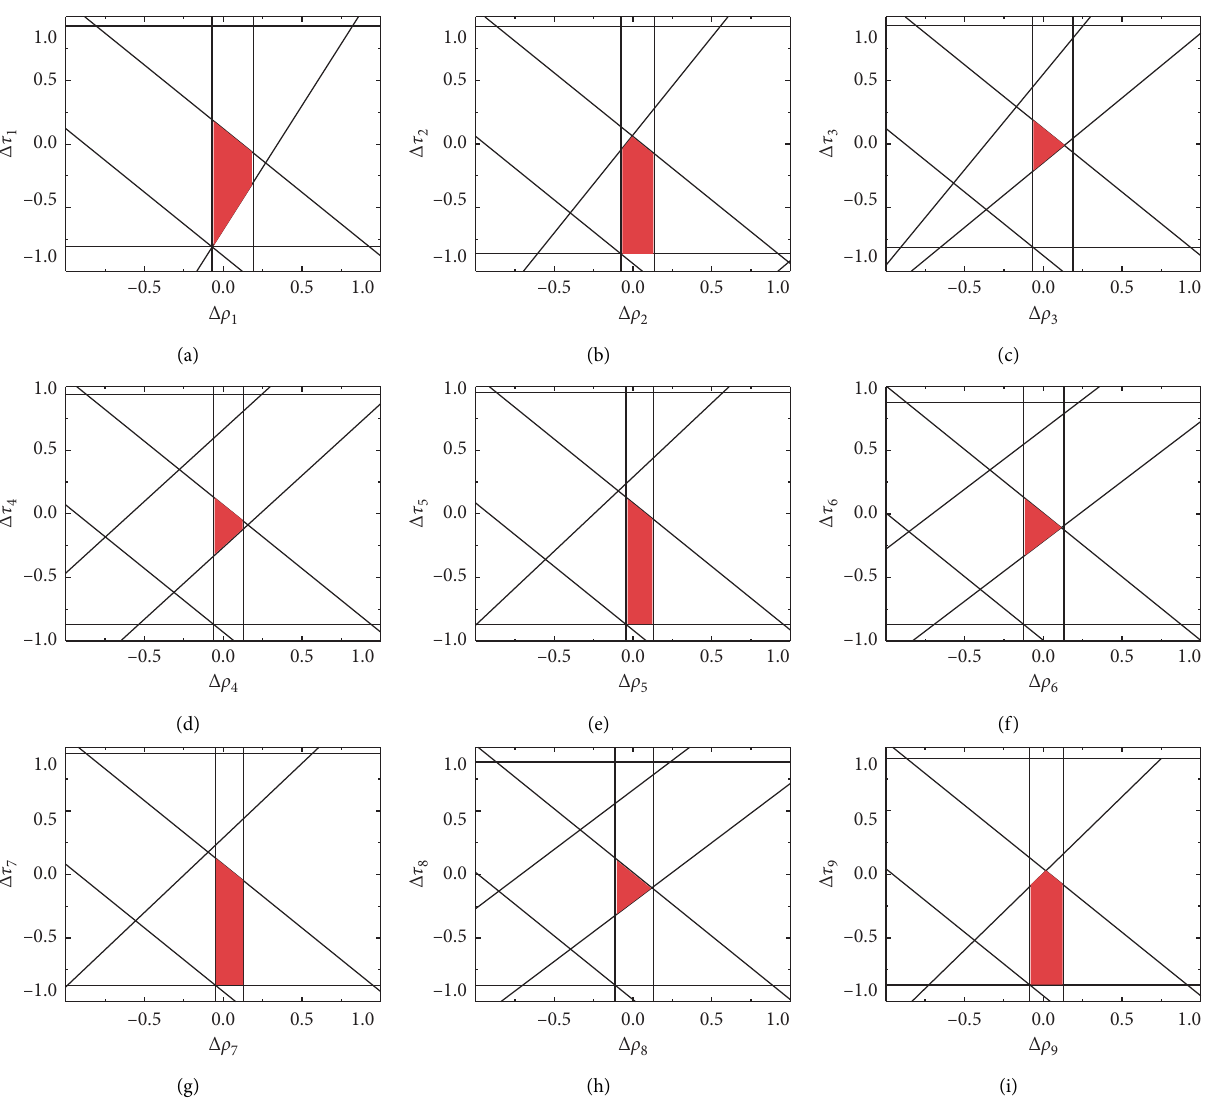
Figure 8: Fuzzy analysis of indicators weight: (a) powder factor, (b) limit vibration velocity, (c) effective casting rate, (d) looseness coefficient, (e) fragmentation distribution, (f) muck pile shape, (g) boulder generation, (e) destruction degree of coal seam bench, and (i) dust